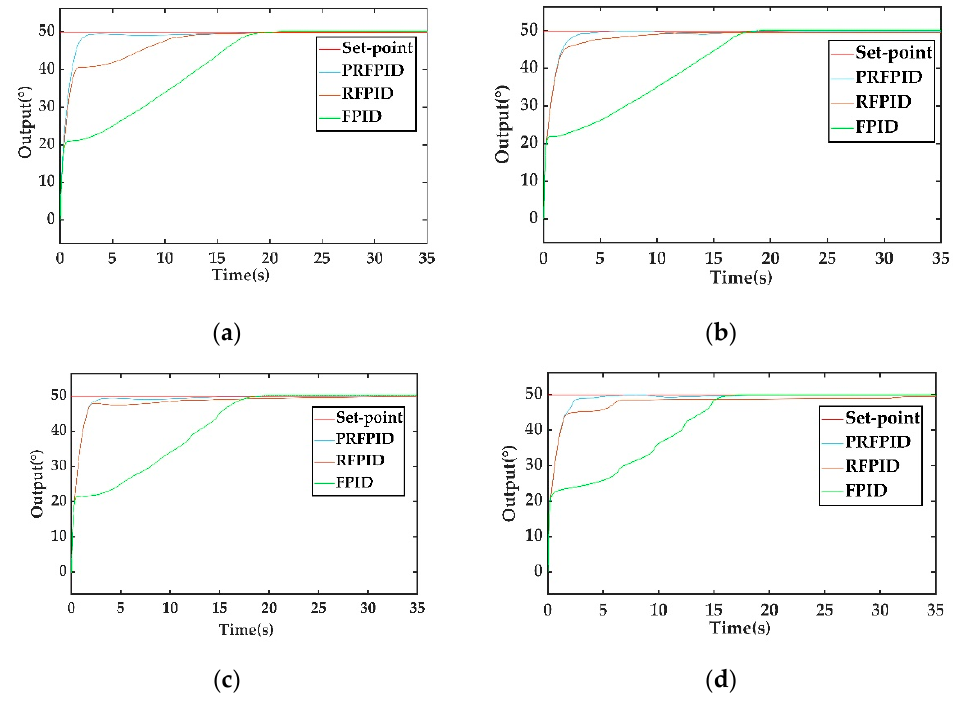
Figure 10. ( a ) Step responses for case 1; ( b ) step responses for case 2; ( c ) step responses for case 3; ( d ) step responses for case 4.